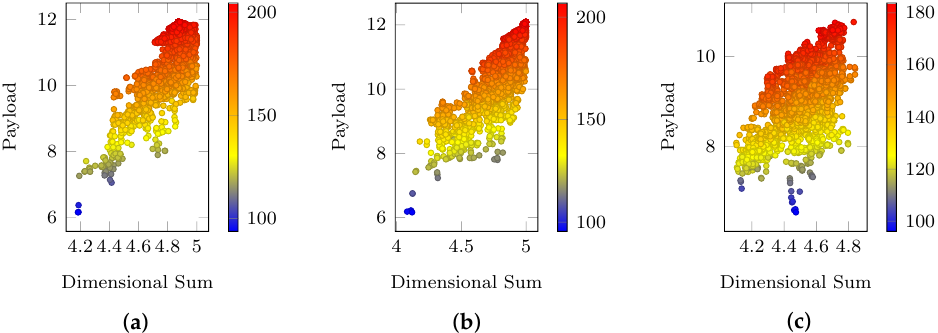
Figure 13. The influence of some intermediary parameters with the final score: the dimensional sum and payload. The score is represented in colors. ( a ) Strategy I, ( b ) Strategy II, ( c ) Strategy